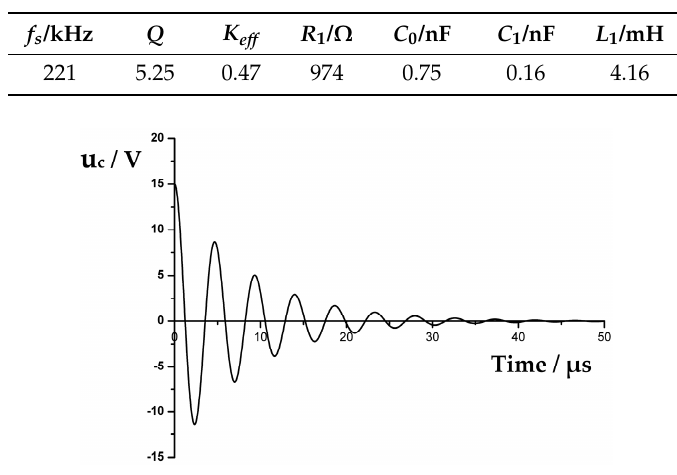
Table 1. Main impedance–admittance parameters of a given transducer.